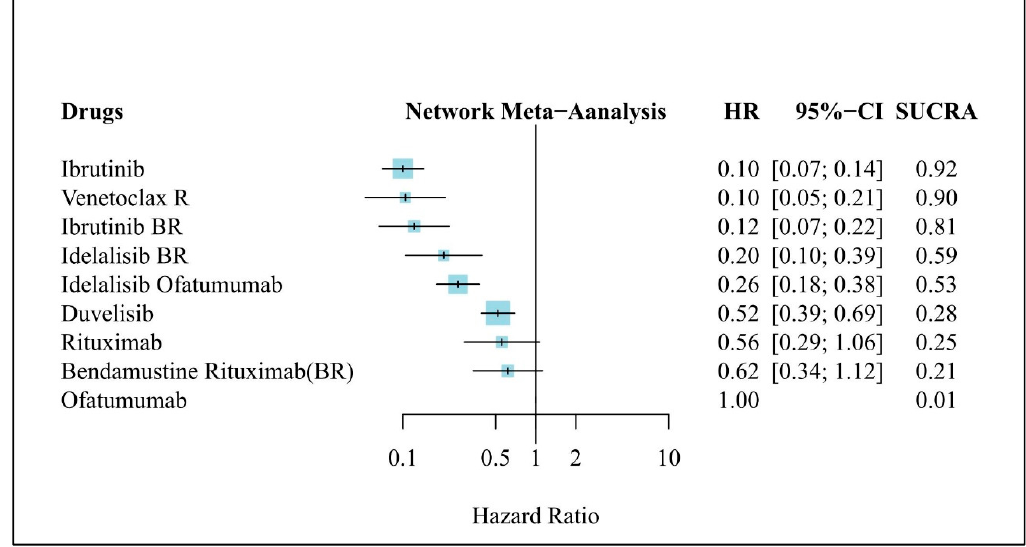
Figure 3. Network meta-analysis results of treatment efficacy in refractory/relapse (R/R) chronic lymphocytic leukemia (CLL): Forest plot of PFS in R/R CLL. HR: Hazard ratio; CI: Confidence interval, SUCRA: Surface under the cumulative ranking curve, BR: Bendamustine + Rituximab, R: Rituximab.